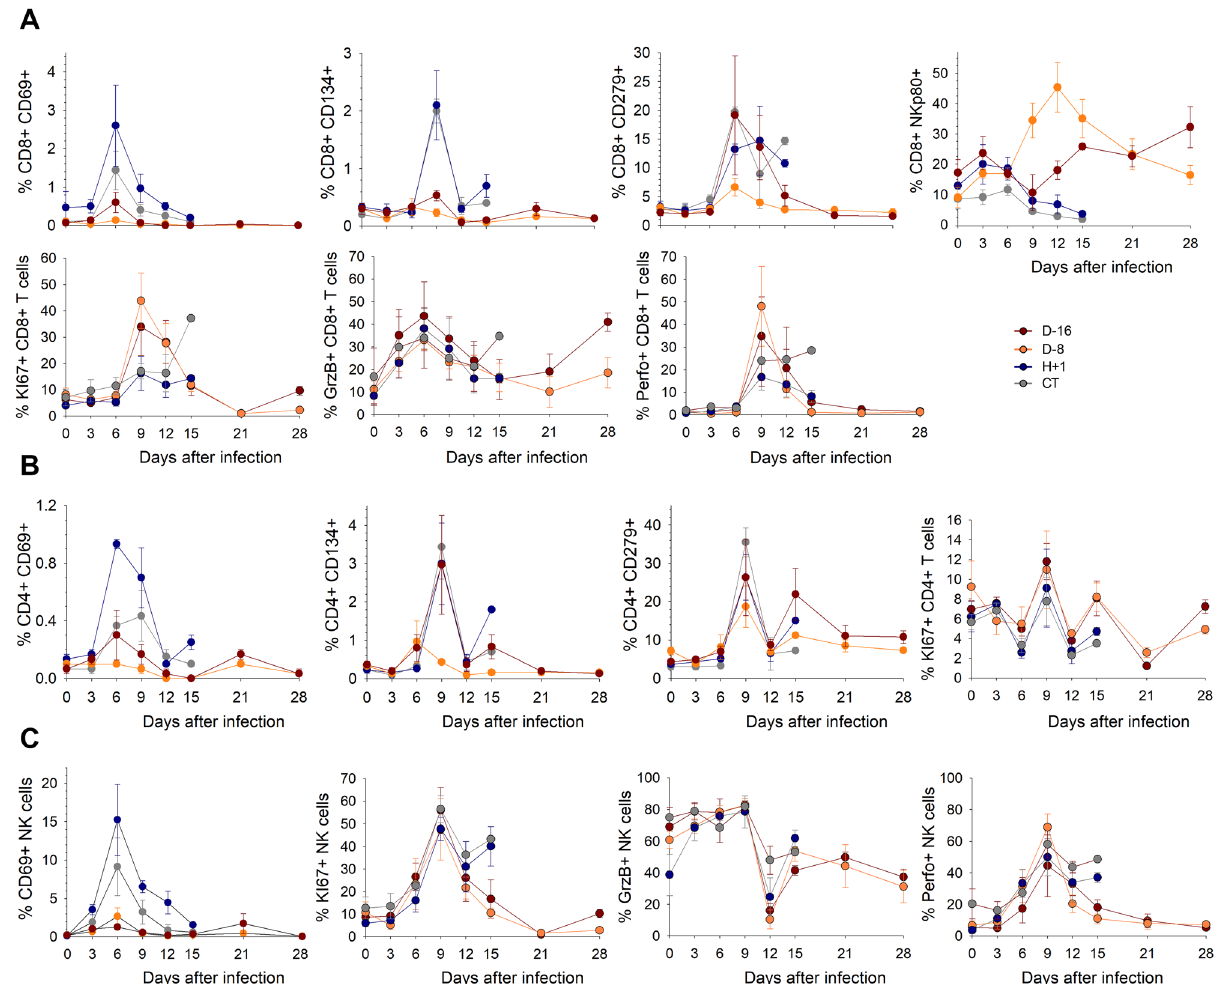
Fig. 6 | Evolution of T-cell and NK cell populations during the course of LASV infection. A Percentage of CD8 + T cells expressing CD69, CD134, CD279, NKp80, KI67, granzyme B (GrzB), or perforin (Perfo) in the blood samples of animals according to the time after the LASV infection measured by fl ow cytometry. Data arepresentedasmeanvalues±SEMof n =3independentsamples. B Percentageof CD4 + T cells expressing CD69, CD134, CD279, or KI67 in the blood samples of